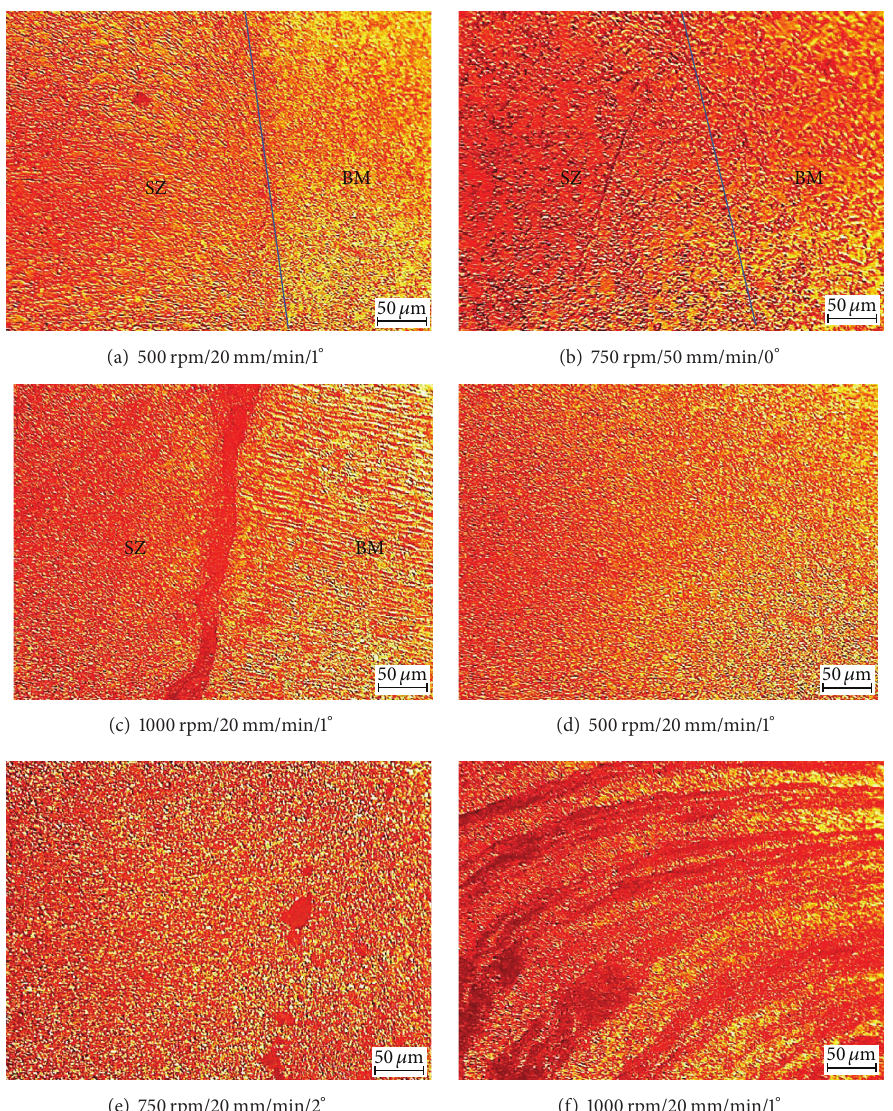
Figure 6: Optical micrographs of nanocomposites at (a–c) the interface between SZ and BM and (d–f) SZ region at different parameter